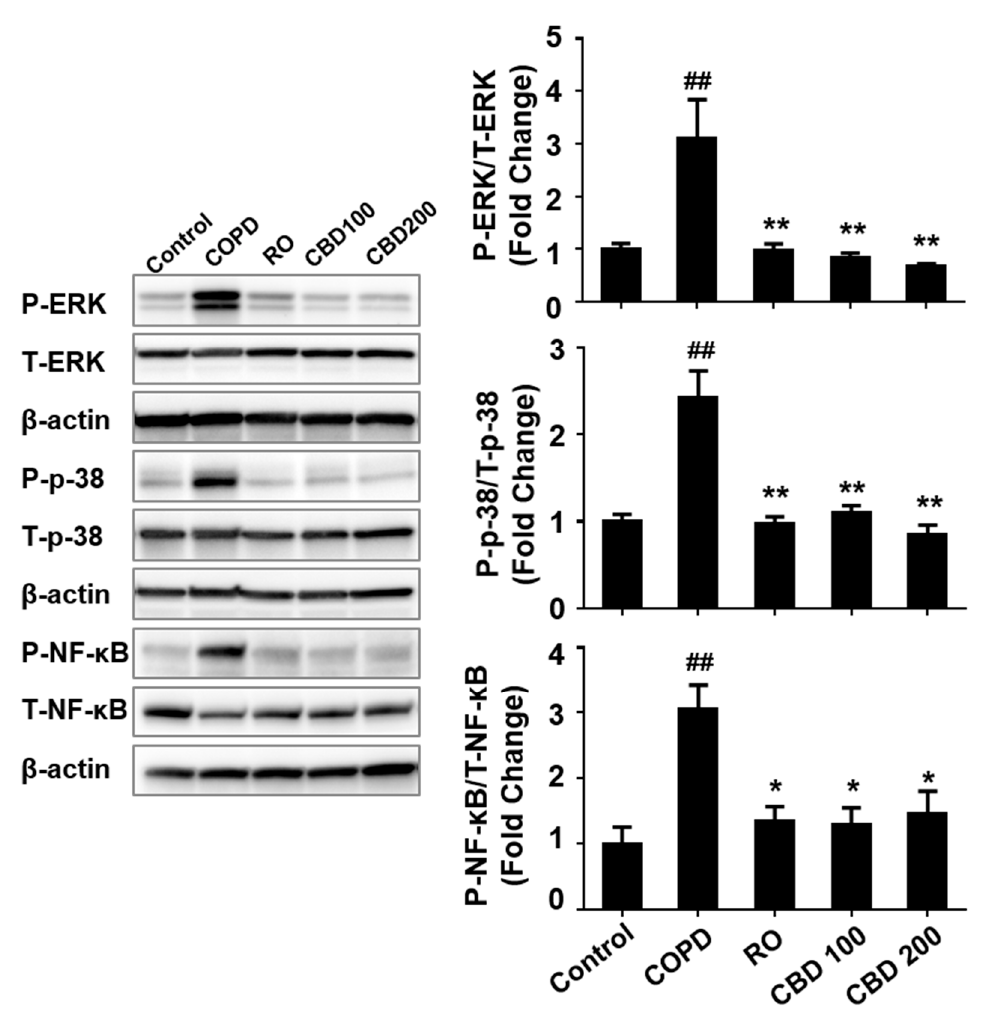
Figure 6. NF-kB and MAPK activity in lung tissues resulting from CBD effects. Western blotting showing the levels of phosphorylation of ERK, p38 MAPK, and NF- κ B in lung tissues. Control: mice instilled intratracheally with normal saline; COPD: mice exposed to CS and LPS; RO: mice exposed to 10 mg/kg roflumilast plus CS and LPS; CBD 100: mice exposed to 100 mg/kg CBD plus CS and LPS; CBD 200: mice exposed to 200 mg/kg CBD plus CS and LPS. Results are presented as means ± SEMs. ## p < 0.01 compared with the control group; * p < 0.05, ** p < 0.01 compared with the COPD group.